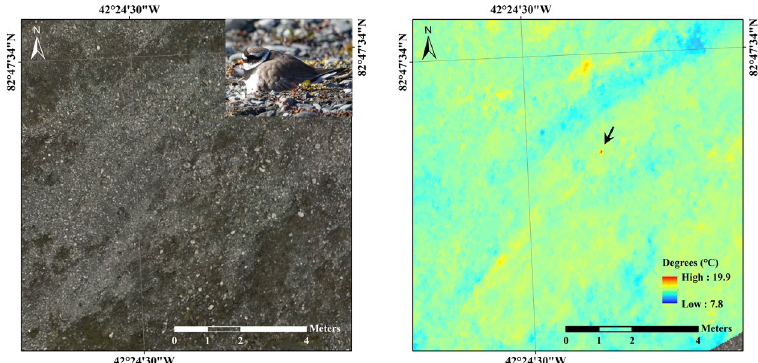
Fig 5. A mosaicked RGB image (left) and a coregistered thermal image (right), which cover one incubating nest (indicated with an arrow). The incubating plover that had been previously detected by the researchers during the survey is presented (upper right in the left RGB